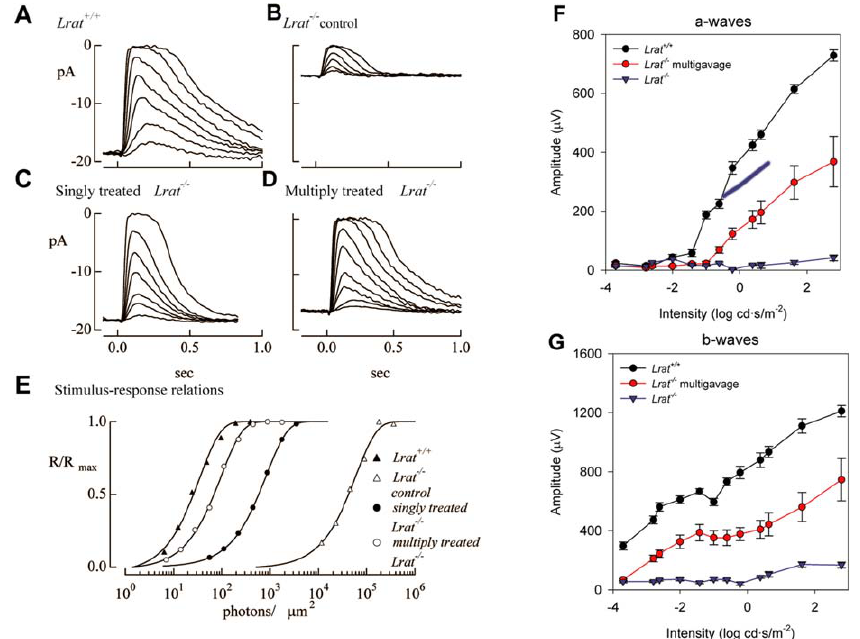
Figure 4. Rescue of Visual Responses Measured by Single-Cell Recording and ERG Responses of single Lrat þ / þ and Lrat (cid:2) / (cid:2) Rods (A–D) Flash families measured for a Lrat þ / þ rod (A), a control Lrat (cid:2) / (cid:2) rod (B), a Lrat (cid:2) / (cid:2) rod after a single gavage with 9- cis -R-Ac (C), and a Lrat (cid:2) / (cid:2) rod after three gavages with 9- cis -R-Ac (D). Each panel superimposes average responses to five to 20 repeats of a flash, with the flash strength increasing by a factor of two for each successively larger response. (E) Stimulus-response relations for the same cells in (A–D). Maximal response amplitudes are plotted against the flash strength. Fits are saturating exponential functions, used to estimate the strength of the flash producing a half-maximal response ( Lrat þ / þ , 26 photons/ l m 2 ; Lrat (cid:2) / (cid:2) , 43,000 photons/ l m 2 ; singly treated Lrat (cid:2) / (cid:2) , 590 photons/ l m 2 ; and multiply treated Lrat (cid:2) / (cid:2) , 69 photons/ l m 2 ). (F and G) Comparison of WT mice scotopic single flash ERG to Lrat (cid:2) / (cid:2) 9- cis -R-Ac gavaged mice and Lrat (cid:2) / (cid:2) and Lrat þ / þ control mice. Lrat (cid:2) / (cid:2) mice were gavaged nine times with 5 l mol 9- cis -R-Ac over a 1-mo time period ( n (cid:4) 3, data shown with SD). DOI: